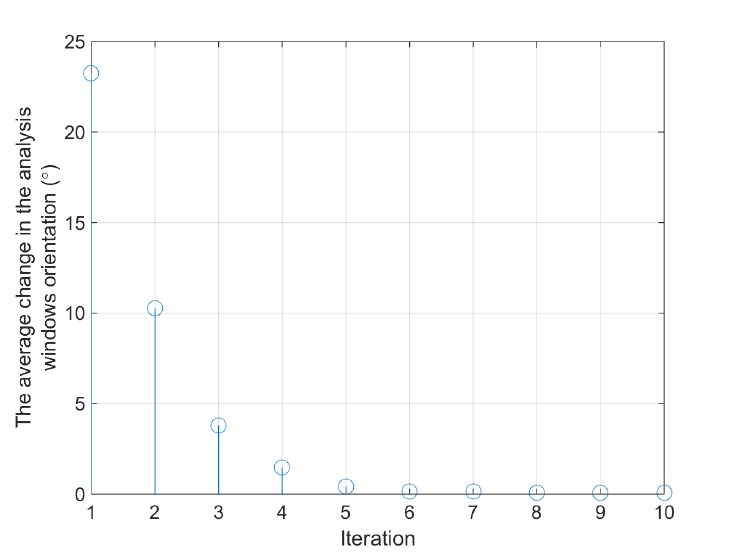
Figure 6. The average change in the analysis windows’ orientation for different numbers of iterations in the